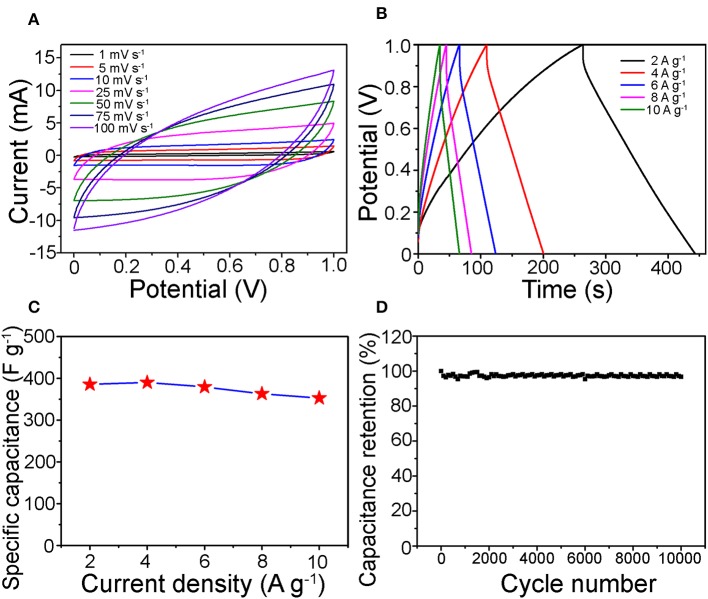
(A) CV and (B) GCD curves of the one-dimensional V0.13Mo0.87O2.935 nanowire electrodes on different sweeping rates and current densities, respectively. (C) Rate performance and (D) cycle stability of the V0.13Mo0.87O2.935 nanowire electrodes, in 1 M Na2SO4 electrolyte.